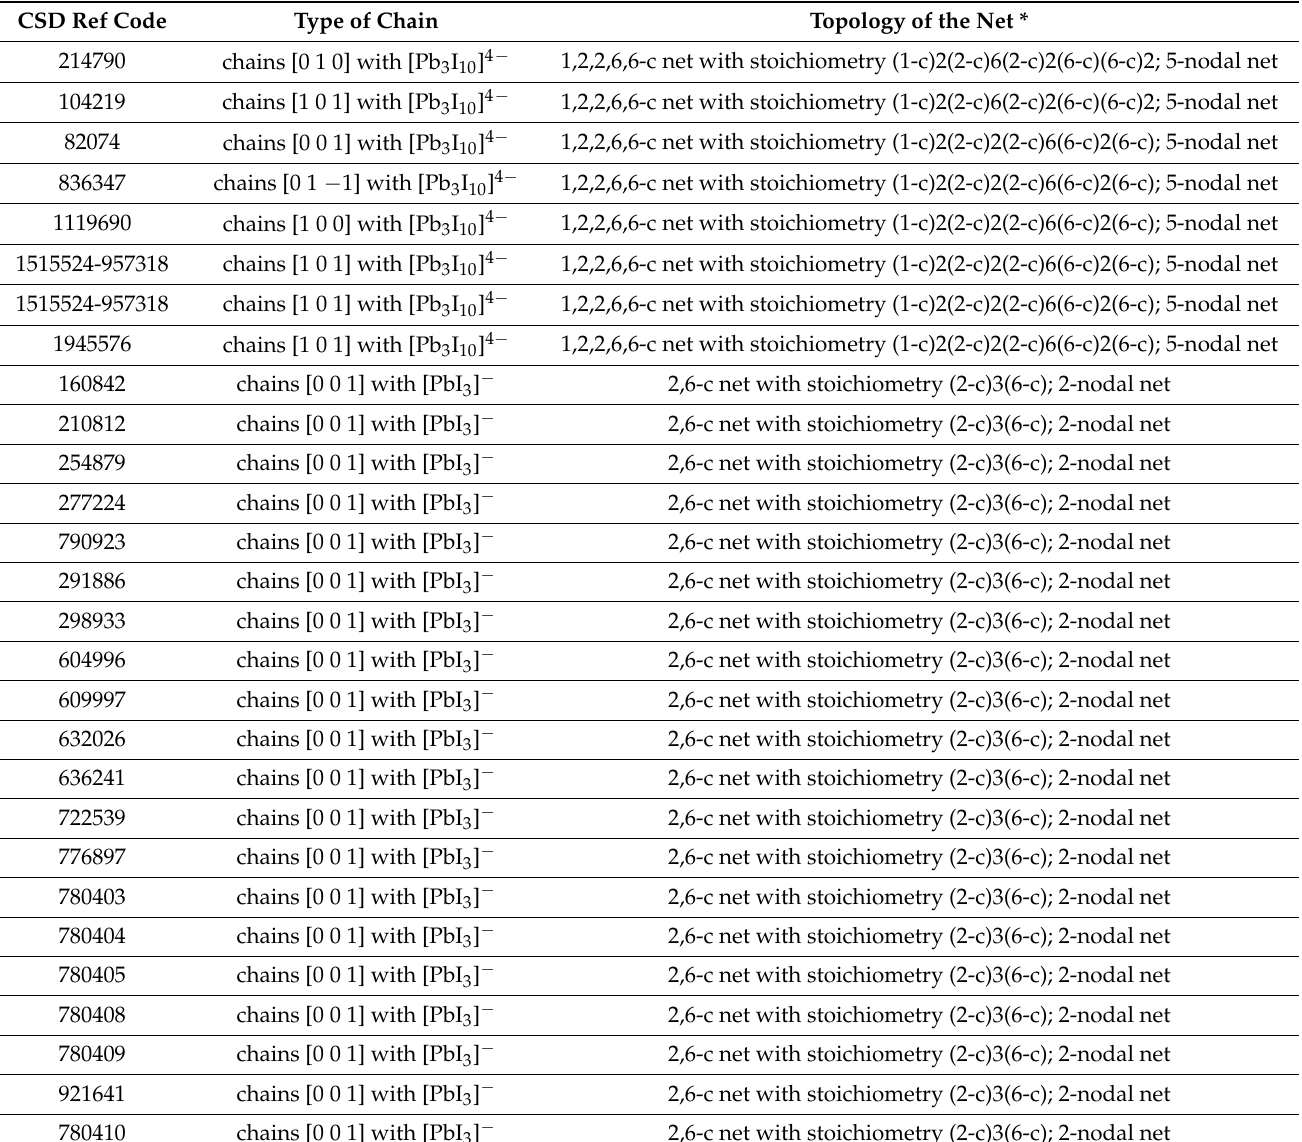
Table A1. Net topology of 1D hybrid lead halide structures from CSD database using TOPOSpro program